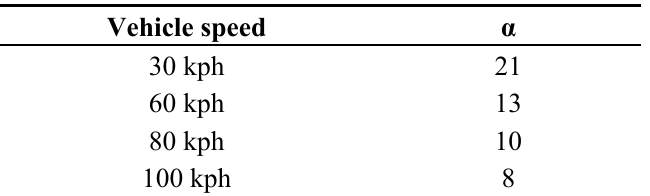
Figure 8. Variations of index α under various vehicle speed and accelerator position conditions; ( a ) 0–30 kph acceleration and cruise drive; ( b ) 0–60 kph acceleration and cruise drive; ( c ) 0–80 kph acceleration and cruise drive; ( d ) 0–100 kph acceleration and cruise drive. Table 2. Index α at different vehicle speeds.